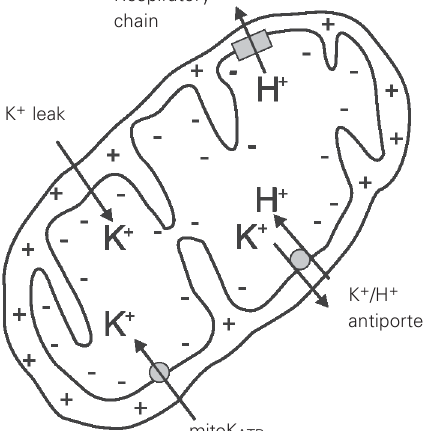
Figure 1. K + transport across mi- tochondrial membranes. Mito- chondrial inner membranes present a K + leak dependent on ∆ψ , generated by H + pumping by the respiratory chain. mitoK ATP opening allows K + en- try into the matrix causing an increase in volume. Excess K + can be removed by the K + /H + antiporter. The outer mitochon- drial membrane is freely perme- able to ions. mitoK ATP = mito- chondrial membrane ATP-sensi- tive K +